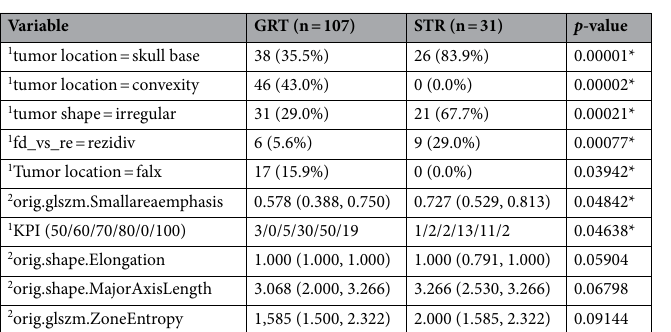
Table 2. Univariate results. 1 Binary and categorical features: number n (in %), 2 continuous variables: median (interquartile range). * p -value < 0.05 (assumed to be statistically significant).